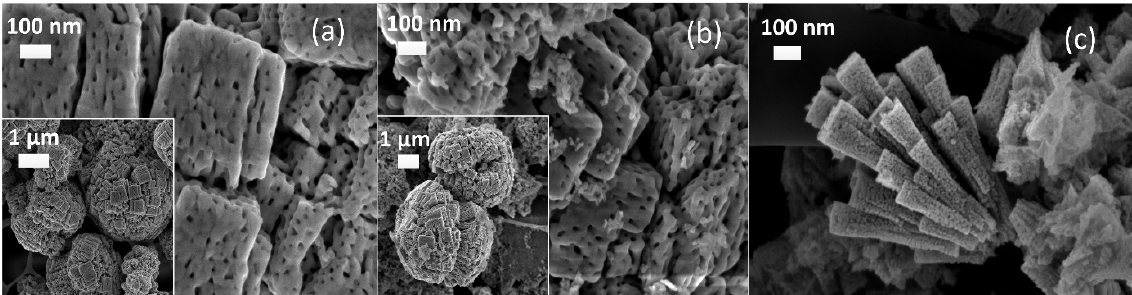
Figure 4. FESEM micrographs of CuZnAl-oxide based catalysts ( a ) Cu-06, ( b ) CuZ-06-03, ( c ) CuZA-06-03-01. Table 2. Main textural parameters of the synthesized CuZnAl-oxide based